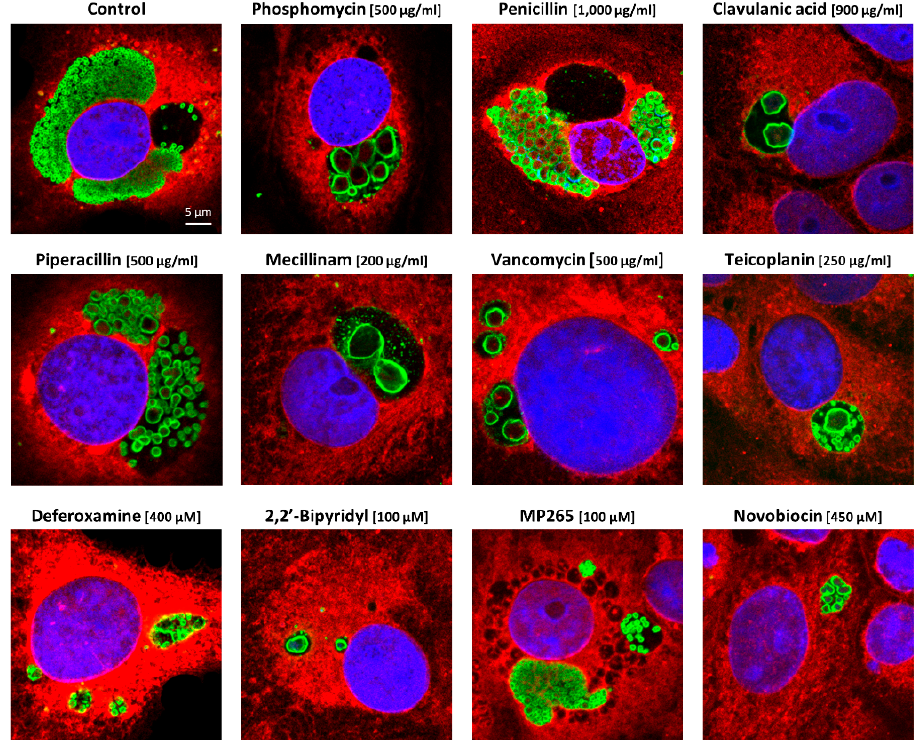
Figure 1. Stress stimuli induce aberrant bodies in Waddlia- infected Vero cells. Vero cells were infected with W. chondrophila and treated at 2 hpi with drugs at concentrations indicated in brackets. Vero cells were fixed with methanol at 24 hpi, labelled with concanavalin A (red), DAPI (blue), and anti- W. chondrophila antibodies (green) and observed by confocal microscopy. All pictures display the same